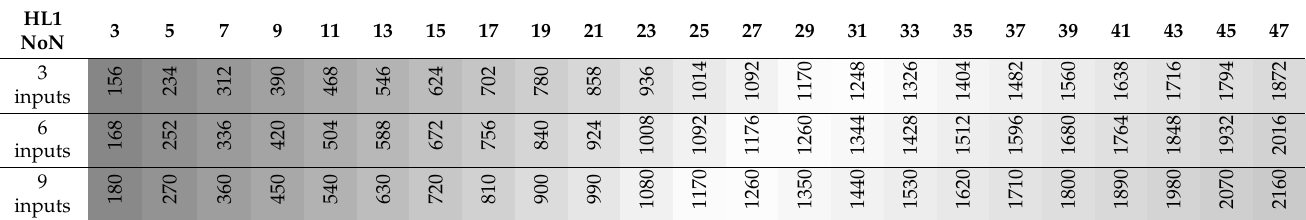
Calculations of the number of parameters for one to three cameras or three to nine inputs for 1HL ANN models are given in Table 4, and the number of parameters of 2HL ANN models is in Table 5. Due to the table size, only the variant for three cameras is presented. However, the number of parameters of the 2HL ANN models with one and two cameras does not differ significantly and, according to the table shown, decreases by 9* N HL 1 with two cameras and by 18* N HL 1 with one camera, which, e.g., for 3 HL1/3 HL2 NoN, means a reduction from 186 to 177 or 168, and for 48 HL1/48 HL2 NoN a change from 4596 to 4452 or 4308. For a comparison with PA models, the tables are shaded according to the range of search for the optimal number of coefficients in PA models. Table 4. Number of coefficients for 1/2/3RGB 1HL ANN models in step 2 for the number of neurons in the first hidden